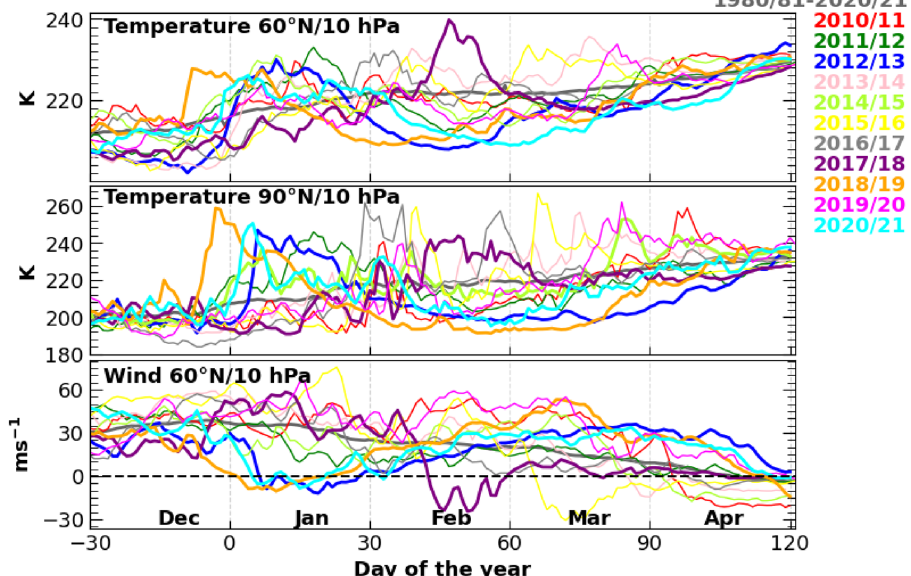
Fig. 1 Temporal evolution of temperature at 60° N and 90° N latitude at 10 hPa and the evolution of zonal winds at 60° N at 10 hPa (data: MERRA 2). The dashed horizontal line in the bottom panel represents zero velocity and the vertical dashed line is indicative of each month. The bold gray line in the background indicates the climatology